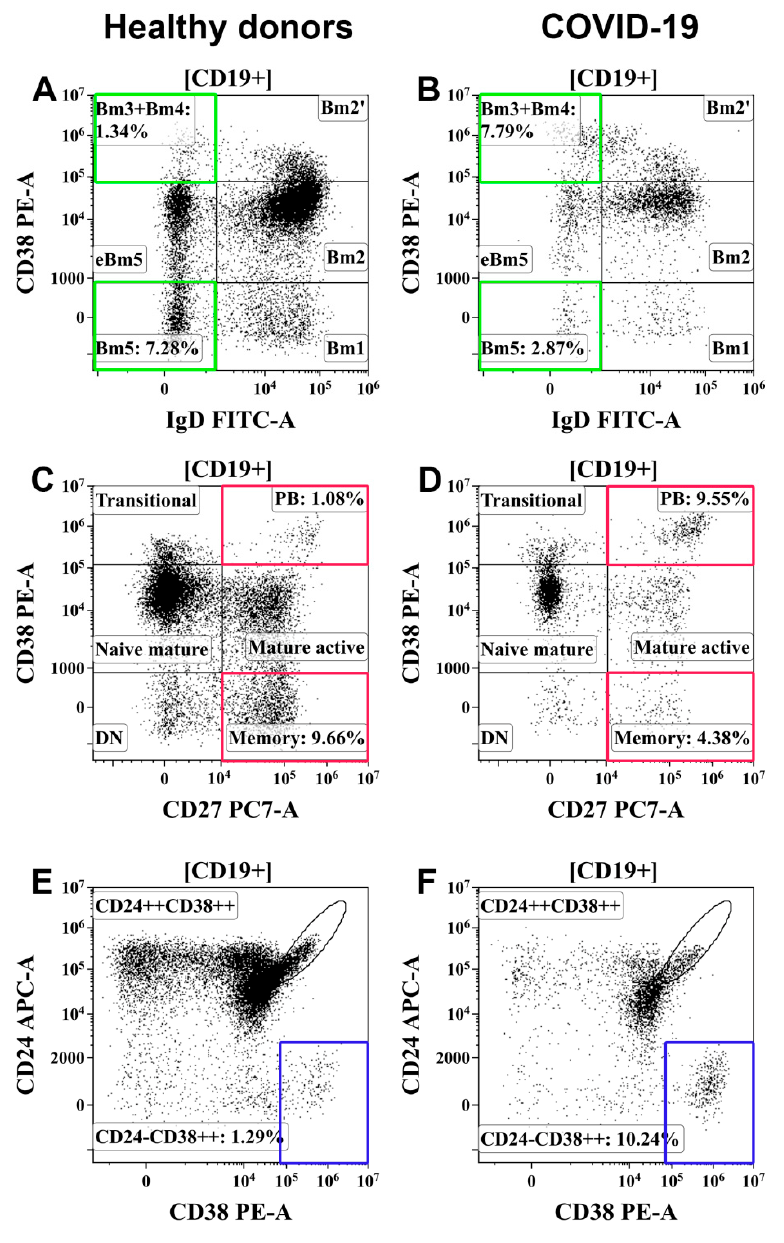
Figure 8. Examples of changes in B-cell subsets in patients with COVID-19. ( A , C , E ) Healthy donors. ( B , D , F ) Patients with COVID-19. ( A , B ) Bm3 + Bm4 and Bm5 B-cell subsets. ( C , D ) Resting memory B cells (CD27+CD38 − ) and circulating plasma cell precursors (CD27+CD38++) (PB). ( E , F ) Circulating plasma cell precursors (CD24 − CD38++). Colored boxes highlight target B-cell subpopulations in patients with COVID-19 and healthy donors.